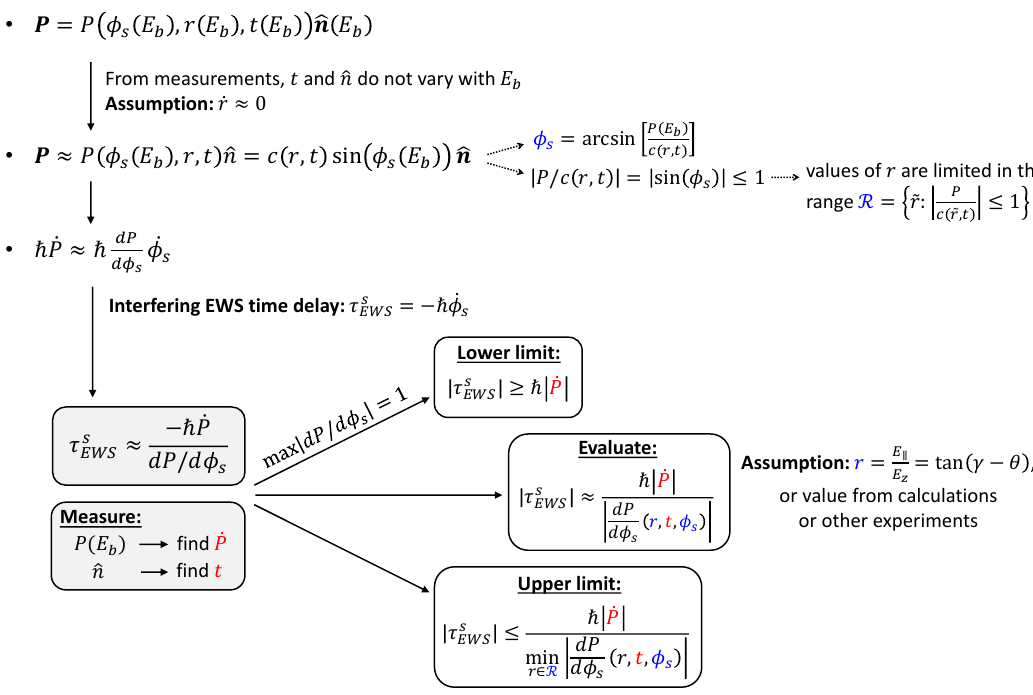
| from the measurement of P . Figure 3: Summary scheme for the estimate of | τ s EWS Modulus and direction of P are determined by both crystal properties and experi- ) and assuming ˙ r ≈ 0 one can estimate the lower and mental setup. Measuring P ( E b | . With a further assumption for r , one can evaluate | τ s | itself. upper limits of | τ s EWS EWS See the text and also Ref. [ 91 ] for more